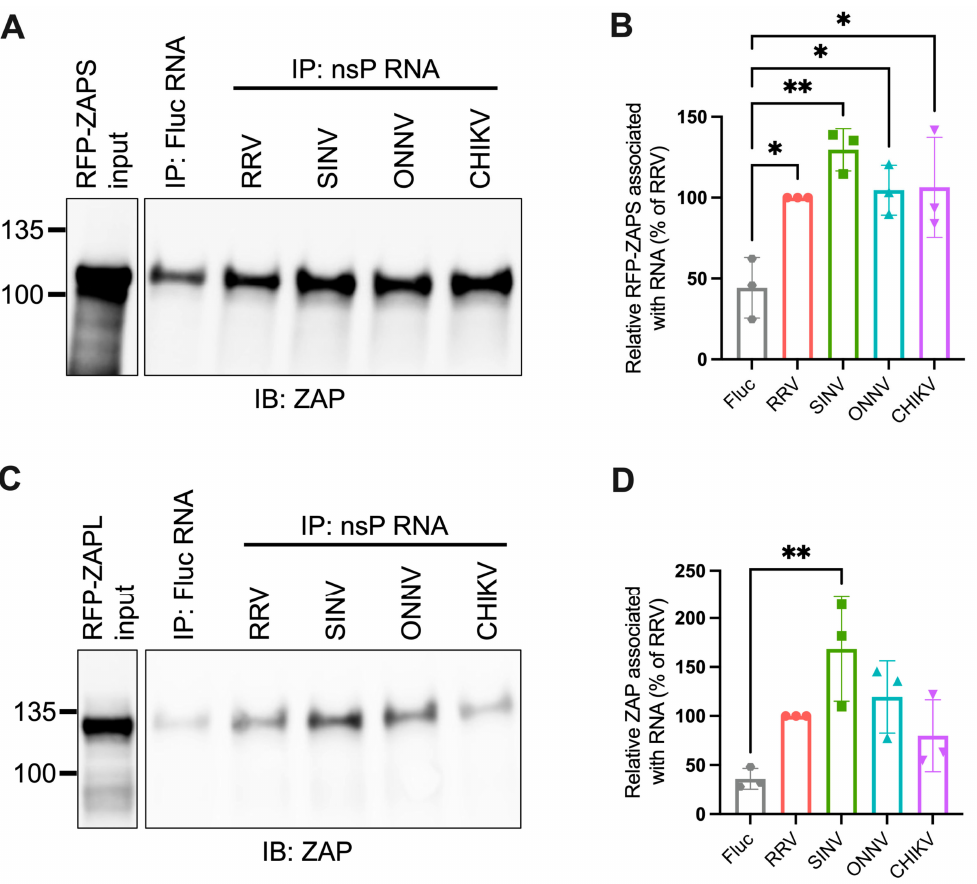
Figure 5. ZAPS and ZAPL binding to alphavirus nsP RNA do not correlate with alphavirus repli- cation sensitivity to ZAP. ( A , C ) Lysates of ZAP KO 293T cells with induced expression of RFP- ZAPS ( A ) or RFP-ZAPL ( C ) were incubated with biotinylated Fluc RNA or nsP RNA of RRV, SINV, ONNV, or CHIKV. Following streptavidin-mediated pull-down of biotinylated RNA, ZAP associ- ated with each RNA and in whole cell lysate (input) was assayed by immunoblot. Expected sizes: RFP-ZAPS = 106 kDa, RFP-ZAPL = 130 kDa. Data are representative of results from three indepen- dent experiments. ( B,D ) ImageJ quantifications of panel A ( B ) or C ( D ). Data are combined from three independent experiments. Error bars represent the SD. Asterisks indicate statistically significant differences (one-way ANOVA and Tukey’s multiple comparisons test: *, p < 0.05; **, p <